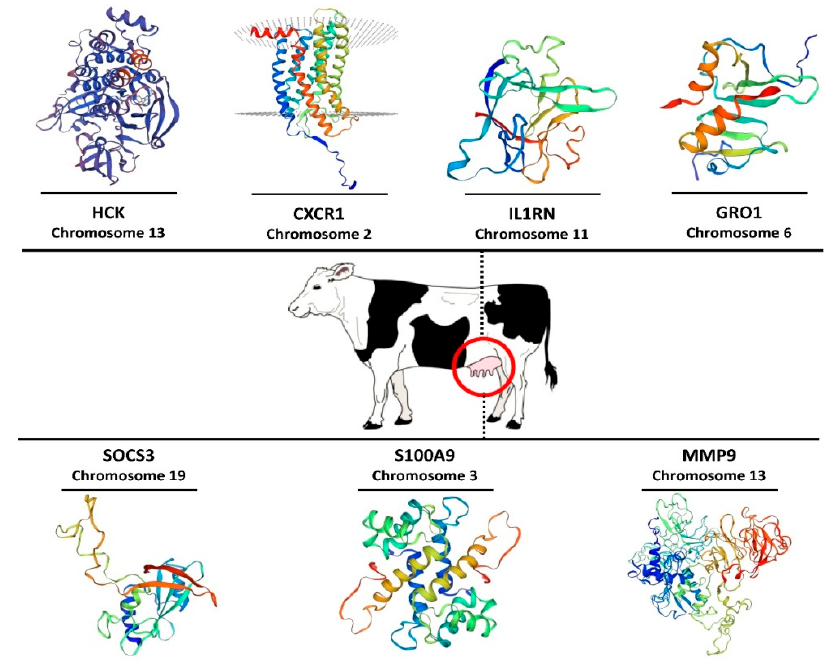
Figure 6. Modeling of three-dimensional protein structure for genes with the most interaction (hub genes) in the interactive bipartite network (gene–miRNA) according to the SWISS-MODEL